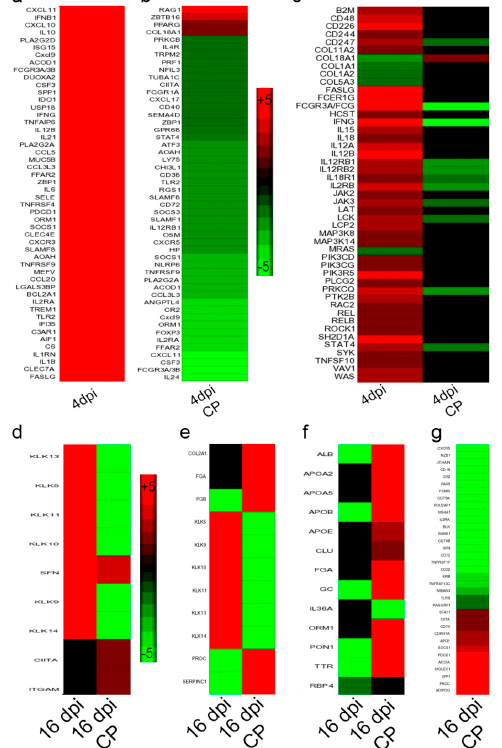
Figure 9. Expression of network genes in immunocompetent and immunocompromised hamsters infected with SARS-CoV-2. ( a ) Heat map of SDEG involved in the inflammatory response in immuno- competent hamster lungs at 4 dpi. ( b ) Heat map of SDEG involved in the inflammatory response in immunocompromised hamster lungs at 4 dpi (4 dpi CP). ( c ) Heat map of SDEG involved in NK cell activation network in immunocompetent (4 dpi) and immunocompromised (4 dpi CP) hamster lungs at 4 dpi. ( d ) Heat map of SDEG involved in canonical MPN-RON signaling in macrophages net- work in immunocompetent (16 dpi) and immunocompromised (16 dpi CP) hamster lungs at 16 dpi. ( e ) Heat map of SDEG involved in prothrombin signaling network in immunocompetent (16 dpi) and immunocompromised (16 dpi CP) hamster lungs at 16 dpi. ( f ) Heat map of SDEG involved in canonical LXR/RXR signaling pathway in immunocompetent (16 dpi) and immunocompromised (16 dpi CP) hamster lungs at 16 dpi. ( g ) Heat map of SDEG involved in B cell recruitment and accumulation network in immunocompetent (16 dpi) and immunocompromised (16 dpi CP) hamster lungs at 16 dpi. Scale bar shows up (red) and downregulation